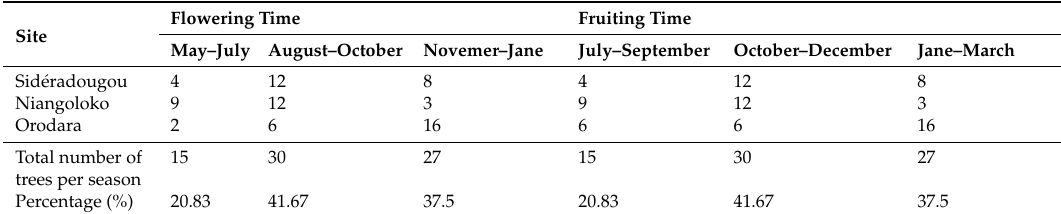
Table 6. Phenology Table 6. Phenology parameters.